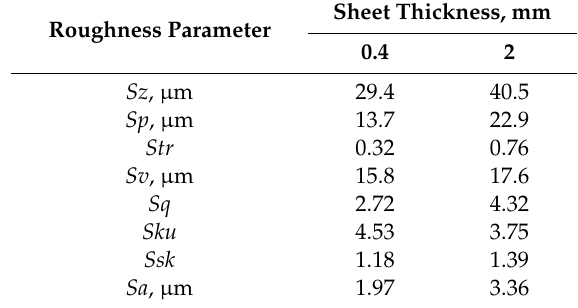
Table 2. Basic roughness parameters of surfaces of 2024-T3 aluminium alloy sheets.